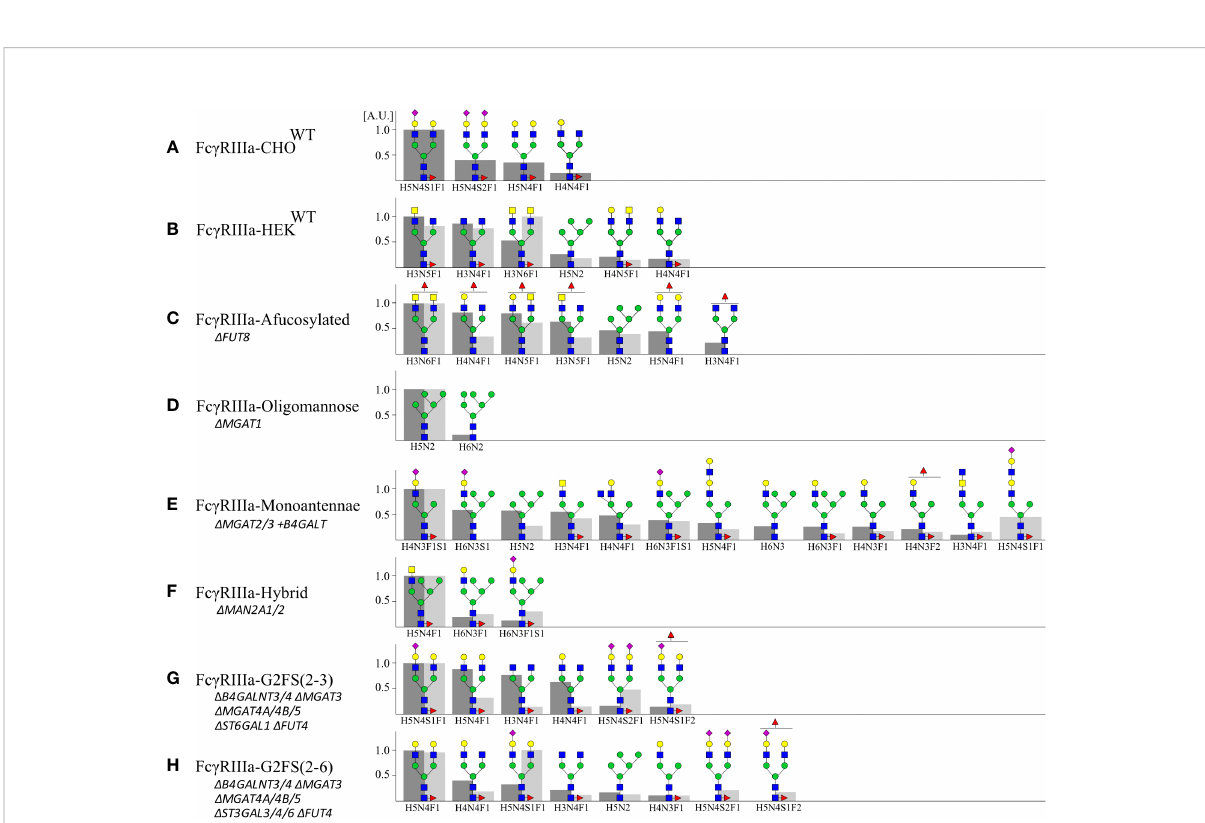
FIGURE 3 Site-speci fi c N- glycan pro fi ling of Asn162 Fc g RIIIa-158F/V by LC-MS/MS. Fc g RIIIa-158F and -158V expressed in (A) CHO and (B – H) HEK293 cells were digested by a combination of chymotrypsin and Glu-C and subjected to LC-MS/MS. Site-speci fi c N- glycan pro fi ling of Asn162 was carried out and the top 90% of the structures are represented relative to the most abundant structure (A.U. = 1) for Fc g RIIIa-158F (dark grey, left) and -158V (light grey, right) with H: hexose, N: N-acetylhexosamine, F: fucose; S: Sialic acid. Proposed glycan structures are based on gene editing signatures and literature. Structures are depicted following the CFG notation